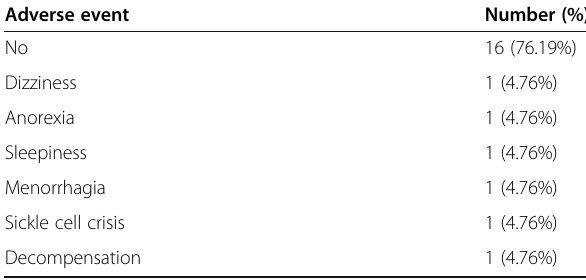
Table 3 Adverse events reported during